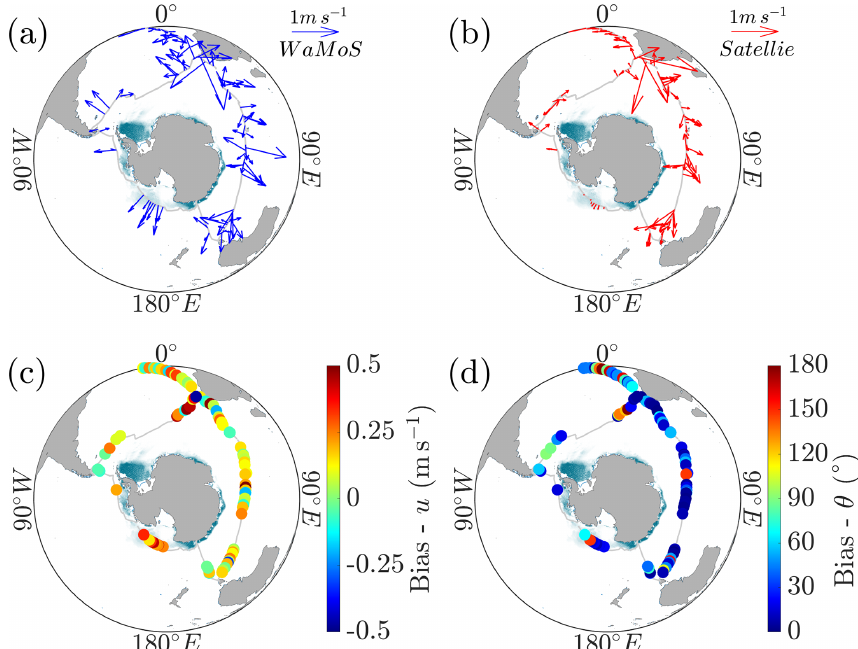
Figure 12. Surface current velocities along the ACE voyage: WaMoS-II (a) and space-borne altimeter sensors (b) . Surface current biases between WaMoS-II and satellite observations for current speed (c) and direction (d) . Average sea ice concentration during the expedition is overlaid in all